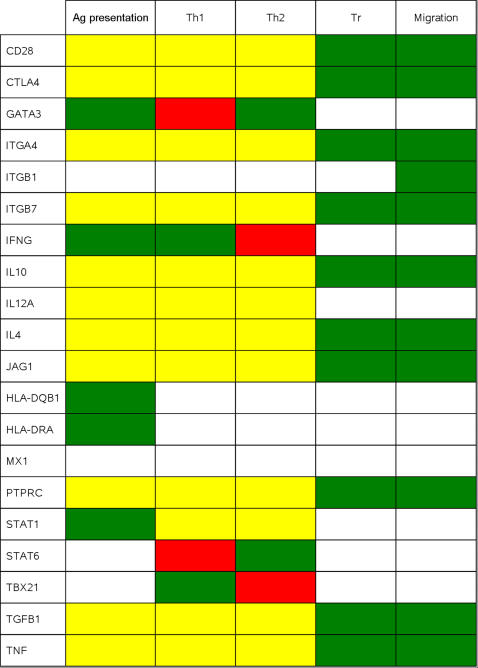
Network Analysis: Dependence matrix.The role of each gene in every T-cell activation function (antigen (Ag) presentation; Th1 differentiation; Th2 differentiation; Treg function; migration) based on the topology of the network is displayed using the following colour code: yellow: dual role (activator or inhibitor); green: full activator; red: full inhibitor; white: no influence.